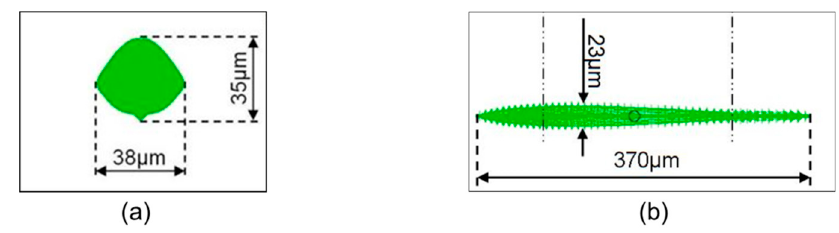
Figure 9. Spot shape measured with log-scale HDRC ® image sensor.